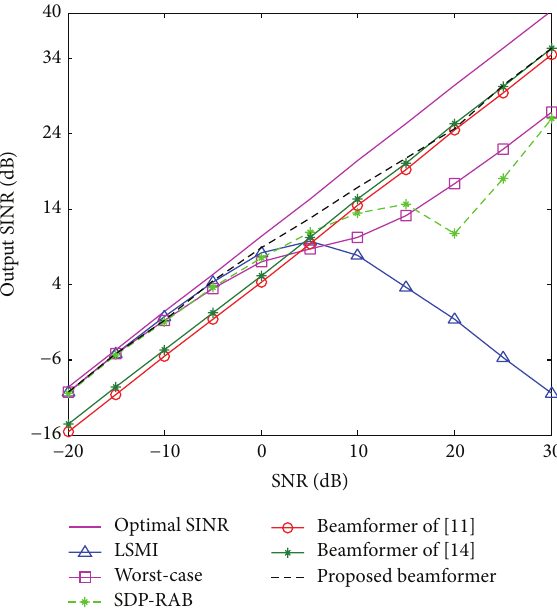
Figure 10: Output SINR versus the number of snapshots for the case of perturbations in antenna array geometry. Figure 11: Output SINR of beamformers versus input SNR with arbitrary ASV error.